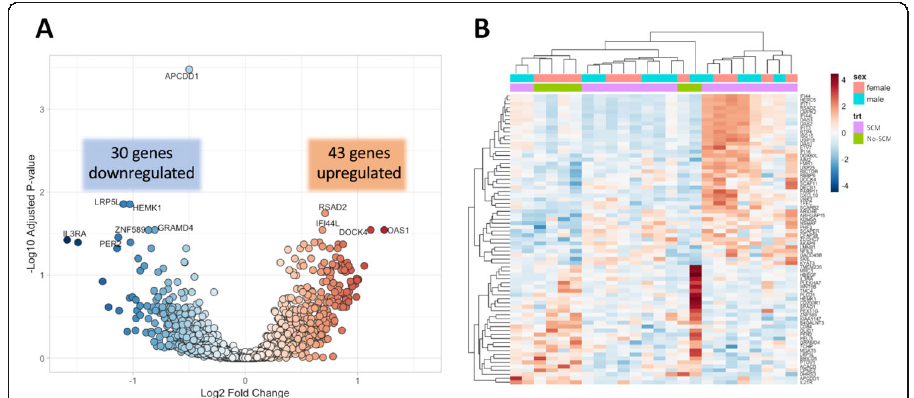
Fig. 2 RNAseq analysis of patients with septic cardiomyopathy compared to those without SCM demonstrates differential gene expression. a Volcano plot illustrating fold differences in gene expression in septic cardiomyopathy vs. non-septic cardiomyopathy subjects. b Heatmap of differentially expressed mRNAs using unsupervised hierarchical clustering. SCM, septic